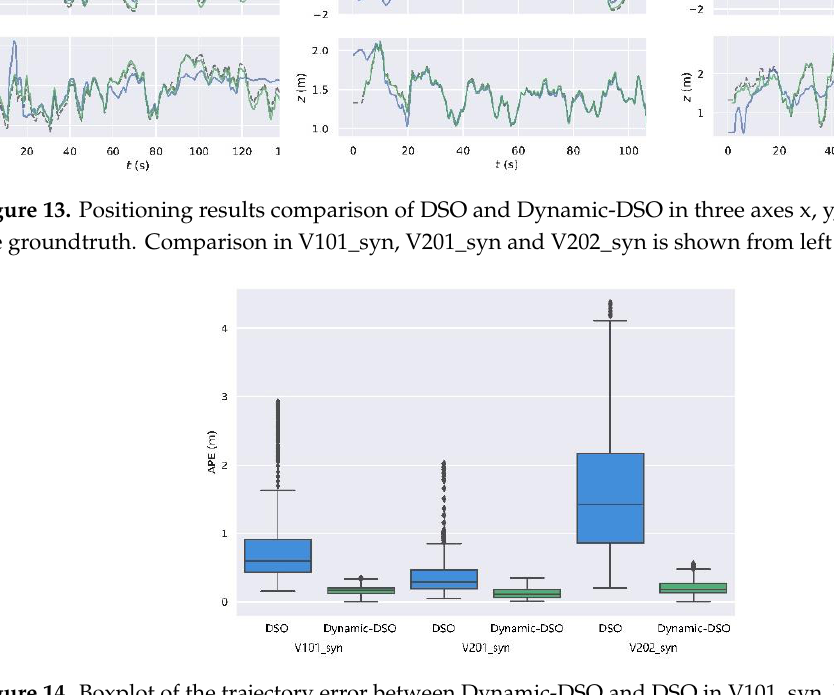
Figure 13. Positioning results comparison of DSO and Dynamic-DSO in three axes x, y, z. GT means the groundtruth. Comparison in V101_syn, V201_syn and V202_syn is shown from left to right.